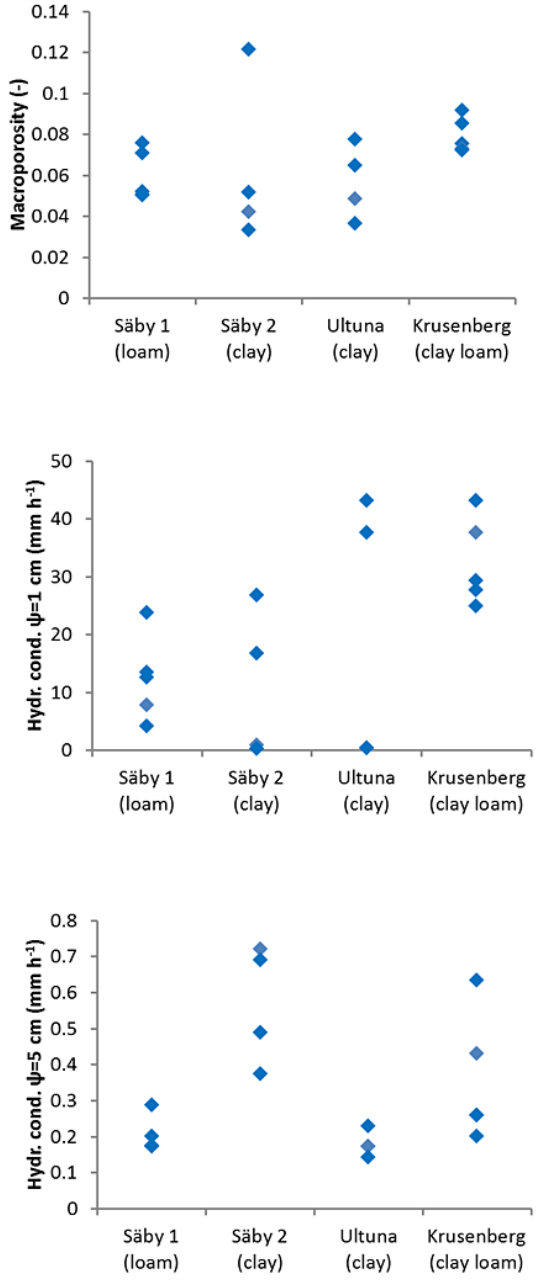
Figure 4. Macroporosities and near-saturated hydraulic conductivi- ties for the four